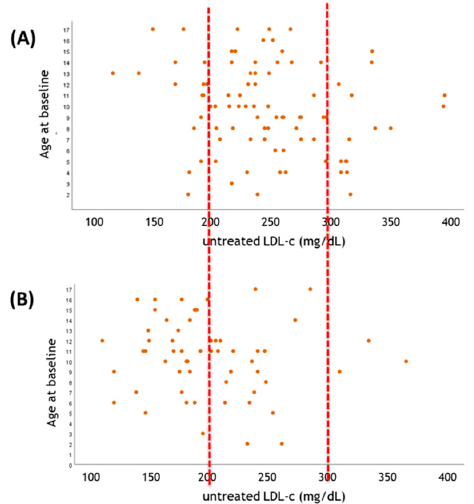
Figure 1. The value of genetic testing in parallel to LDL-C. ( A ) Pediatric FH subjects (age < 18 years-old) carrying LDLR negative FH-mutation (c.1646G > A p.Gly549Asp), displaying median pre-treatment LDL-C level of 249.5 ± 54.0 mg/dL; ( B ) Pediatric FH subjects carrying LDLR defective FH-mutation (c.1775G > A p.Gly592Glu), displaying median pre-treatment LDL-C level of 198.2 ± 50.7 mg/dL. In both panels, graphs correlate the LDL-C before starting statin treatment ( x axis) vs. the biological age of the probands at basal clinical diagnosis (coinciding with the entry in the LIPIGEN registry following genetic analysis by NGS). Representative dashed red lines help to figure out changes in LDL-C distribution between subjects in both